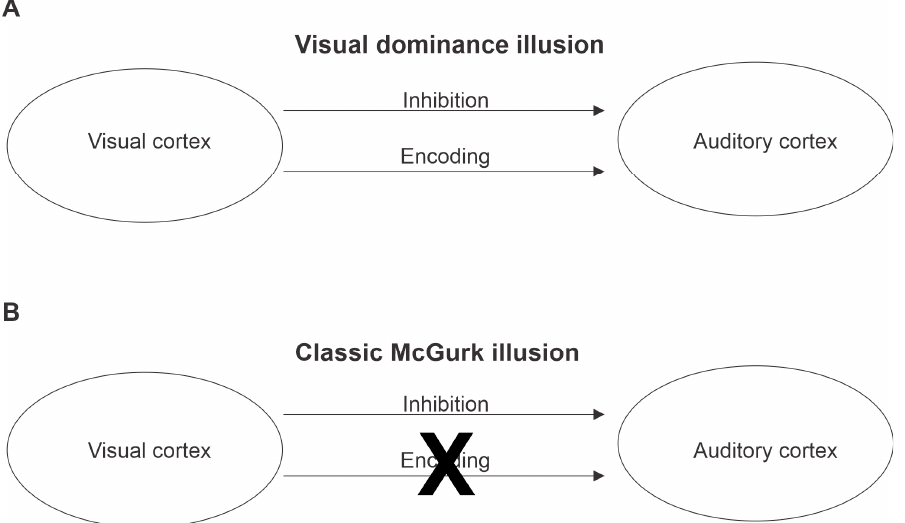
Figure 4. Theoretical Framework illustrating underlying mechanism of the ( A ) Visual dominance illusion and ( B ) Classic McGurk illusion. The Visual Dominance illusion involves visually-mediated inhibition of the auditory cortex, followed by encoding of the visually-conveyed information at the auditory cortex, leading to auditory perception of the visually-conveyed phoneme. According to the proposed “Auditory Default” mechanism underlying the Classic McGurk Illusion, visually-mediated inhibition of the auditory cortex occurs, but because the visual phonetic representation is ambiguous, the visually-mediated encoding step fails, and thus auditory perception is dominated by the phonetic representations with the intrinsically strongest weights within the auditory cortex (‘/d/t/th/’).